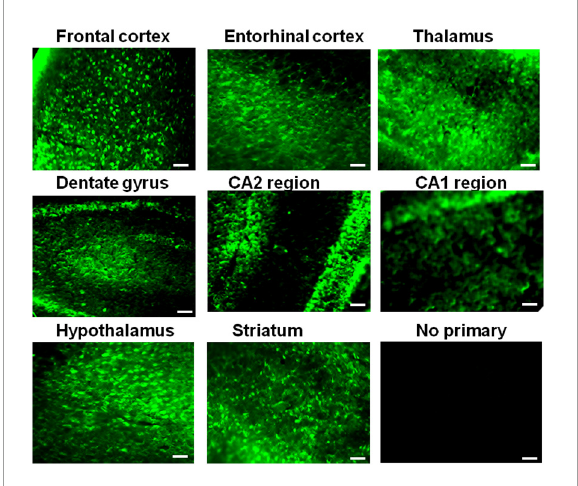
FIGURE3 Different expression levels of the IQCK protein in mouse brain regions as revealed by immunohistochemistry. Representative micrographs are shown for different brain regions, as the images suggest differences in expression levels in the cortex and other brain regions. The lack of signals in the negative controls confirms the specificity of the used antibody for IQCK expression in the brain. Scale bars indicate 50 µ